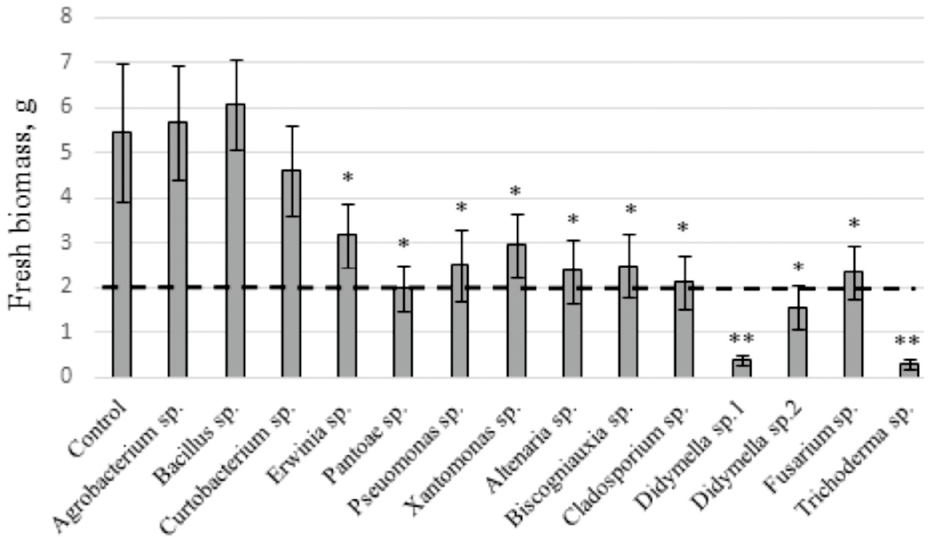
Figure 1. Accumulation of fresh biomass in the V7 cell suspension culture of Vitis amurensis after one week of cocultivation with the V. amurensis endophytic bacteria or fungi. The dotted line depicts an inoculum mass of 2 g. * p < 0.05; ** p < 0.01 versus values of fresh biomass accumulated in the V7 cell under the control conditions without bacteria and fungi.